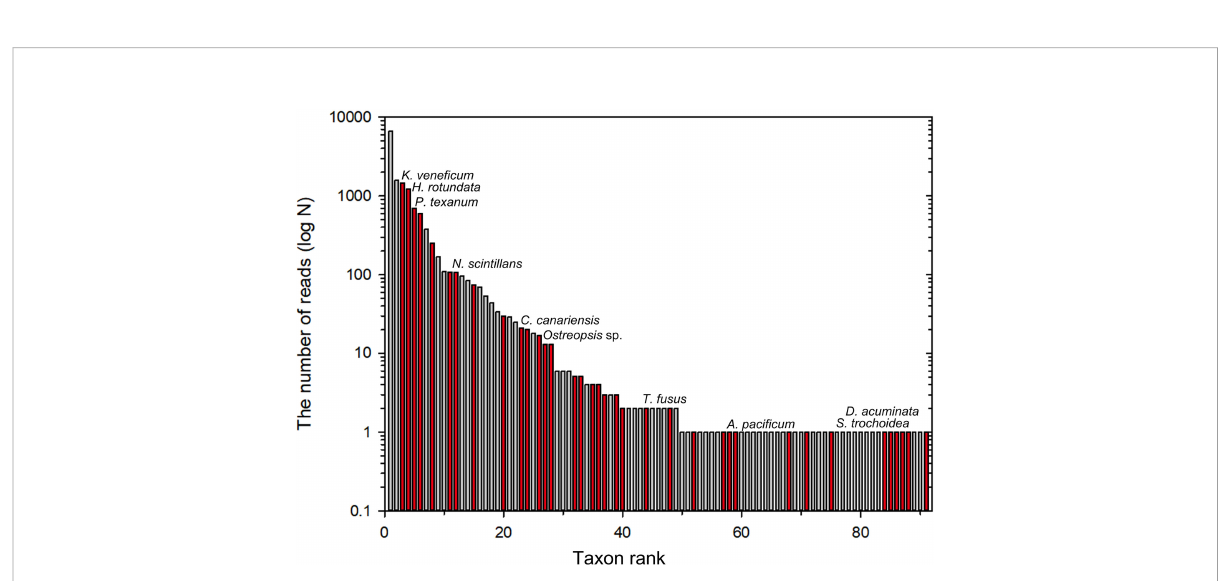
FIGURE 8 Bar graphs showing order by the number of reads of dino fl agellate operational taxonomic units (OTUs) detected in plastic samples. Red bars represent harmful (bloom-forming) or toxic dino fl